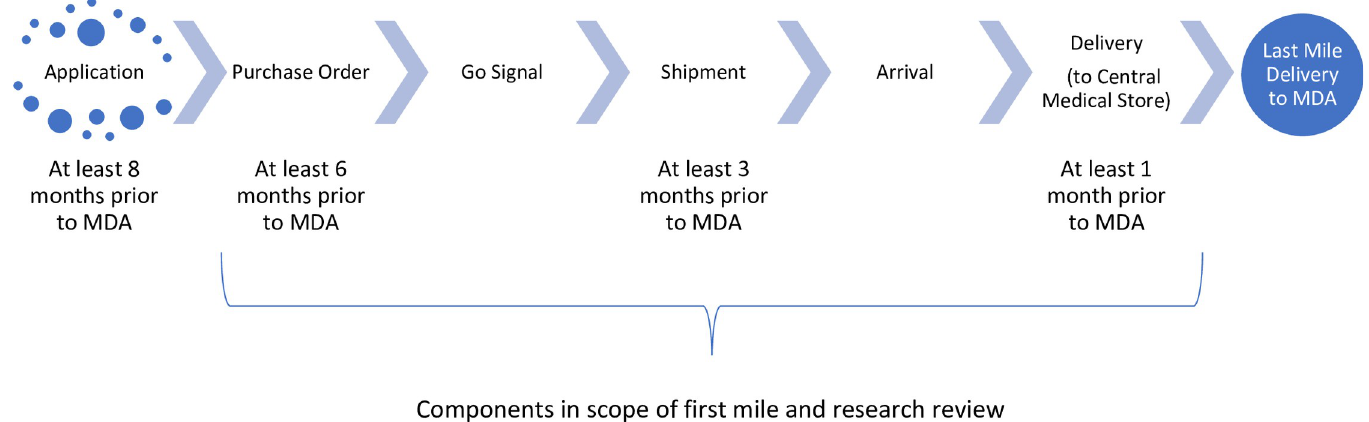
Fig 2. Simplified timeline of the NTD supply chain, associated benchmarks, and scope of